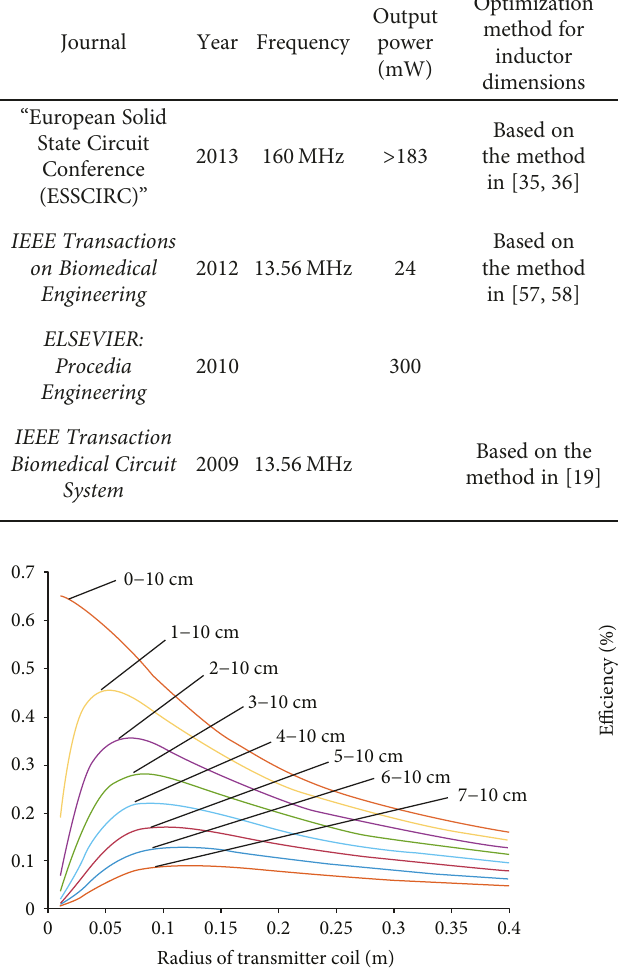
Figure 3: Magnetic fi eld integration for speci fi ed transfer range.